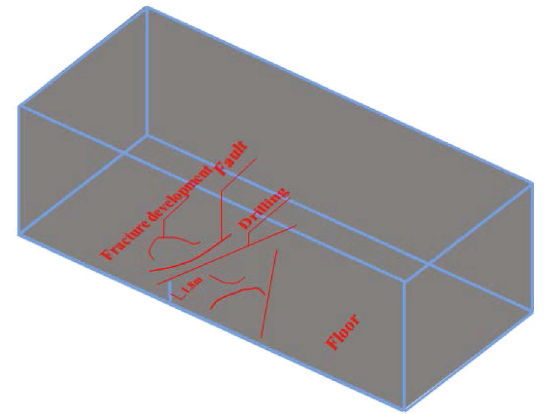
Figure 4: Details of dedusting